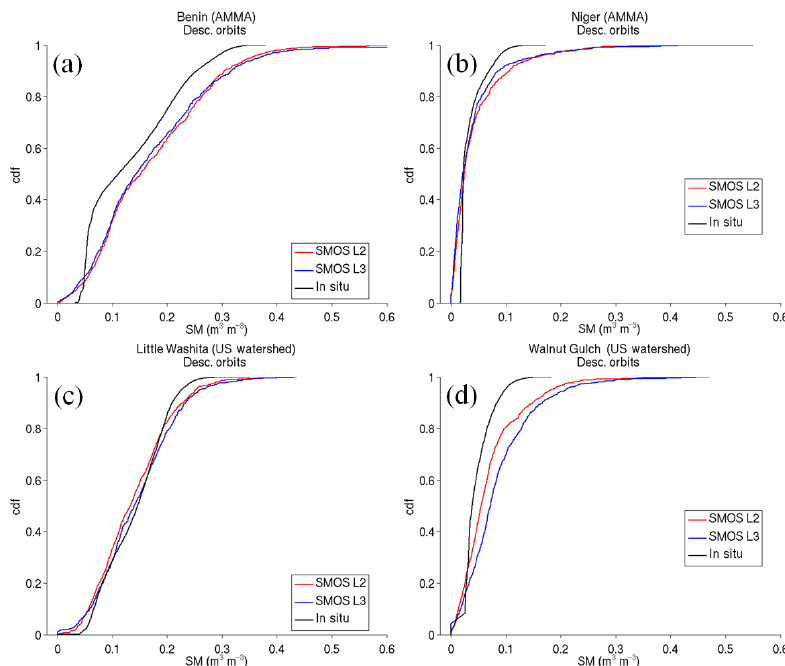
Figure 14. Cumulative distribution function (CDF) for the validation sites for descending overpasses.